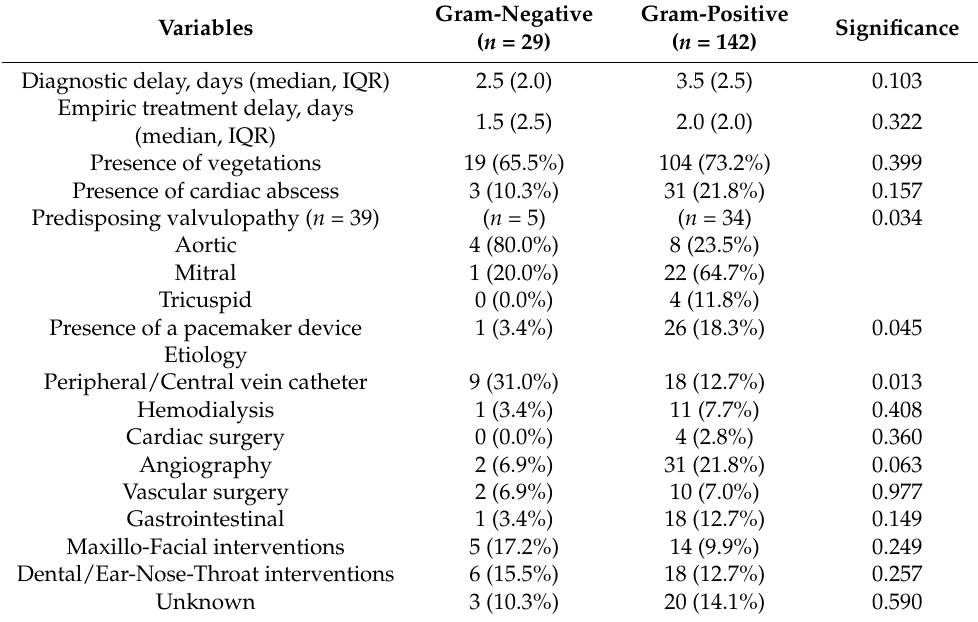
Table 2. Characteristics of the infection between patients with Gram-negative and Gram- positive